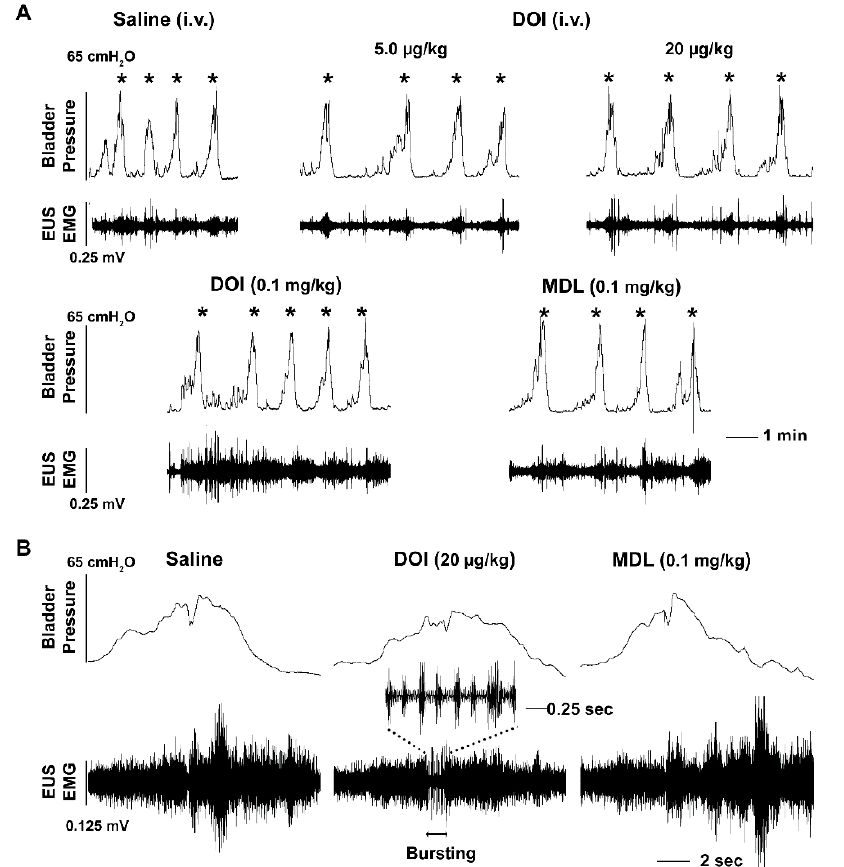
Figure 2. Intravenous (i.v.) administration of DOI to stimulate 5-HT 2A receptors improves the micturition reflex during bladder cystometry and sphincter EMG in SCI rats. ( A ), Stimulating 5-HT 2A receptors with the middle dose of DOI (20 µ g/kg) prolongs the VI ( p < 0.05, Friedman’s test followed by Dunn’s) between voiding contractions (asterisks). The high dose of DOI (0.1 mg/kg) increases EUS tonic activity in the filling phase ( p < 0.01). Ensuing injection of MDL (0.1 mg/kg) eliminates the provoked effects. ( B ), Representative traces show no EUS bursting activity during voiding when saline is delivered. However, the middle dose of DOI triggers EUS bursting activity during voiding. Injection of MDL following the high dose of DOI masks the triggered bursting EUS activity during voiding.